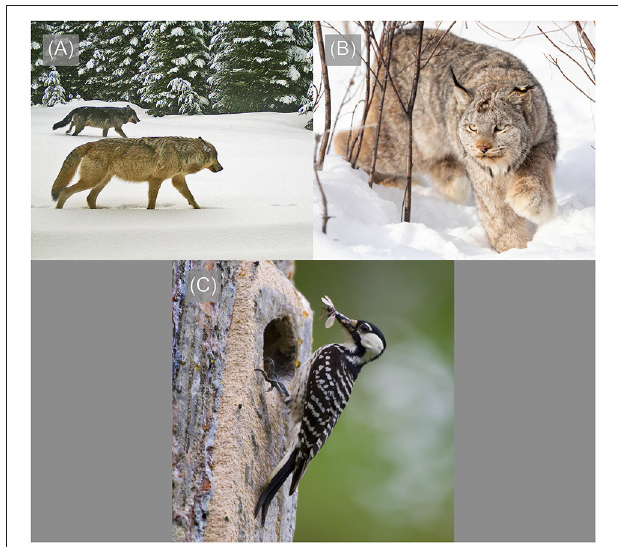
FIGURE 1 | Three examples ofFigure species affected by the interpretation of “representation” under the Endangered Species Act include (A) the Lower 48 population of the gray wolf ( Canis lupus ; credit: Oregon Department of Fish and Wildlife), (B) the Canada lynx ( Lynx canadensis ; credit: Lisa Hupp, U.S. Fish and Wildlife Service), and (C) the Red-cockaded Woodpecker ( Picoides borealis ; credit: U.S. Fish and Wildlife